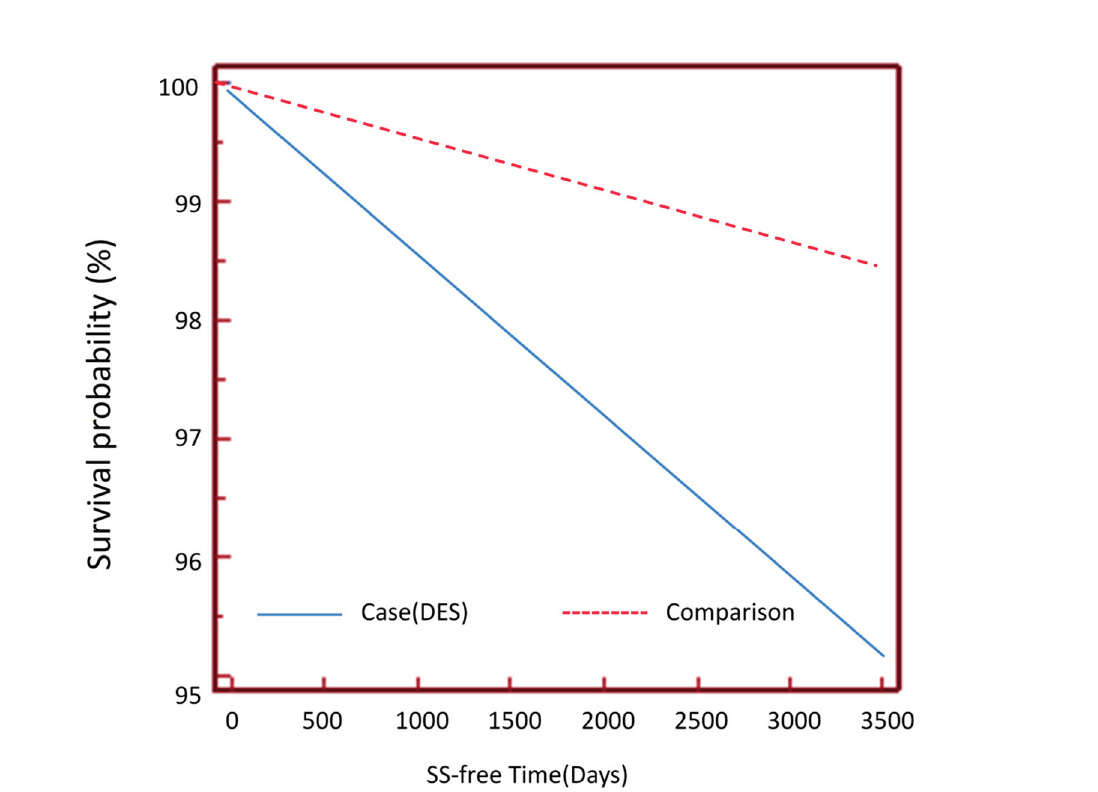
Figure 1. Kaplan-Meier Survival analysis of DES patients against SS-free